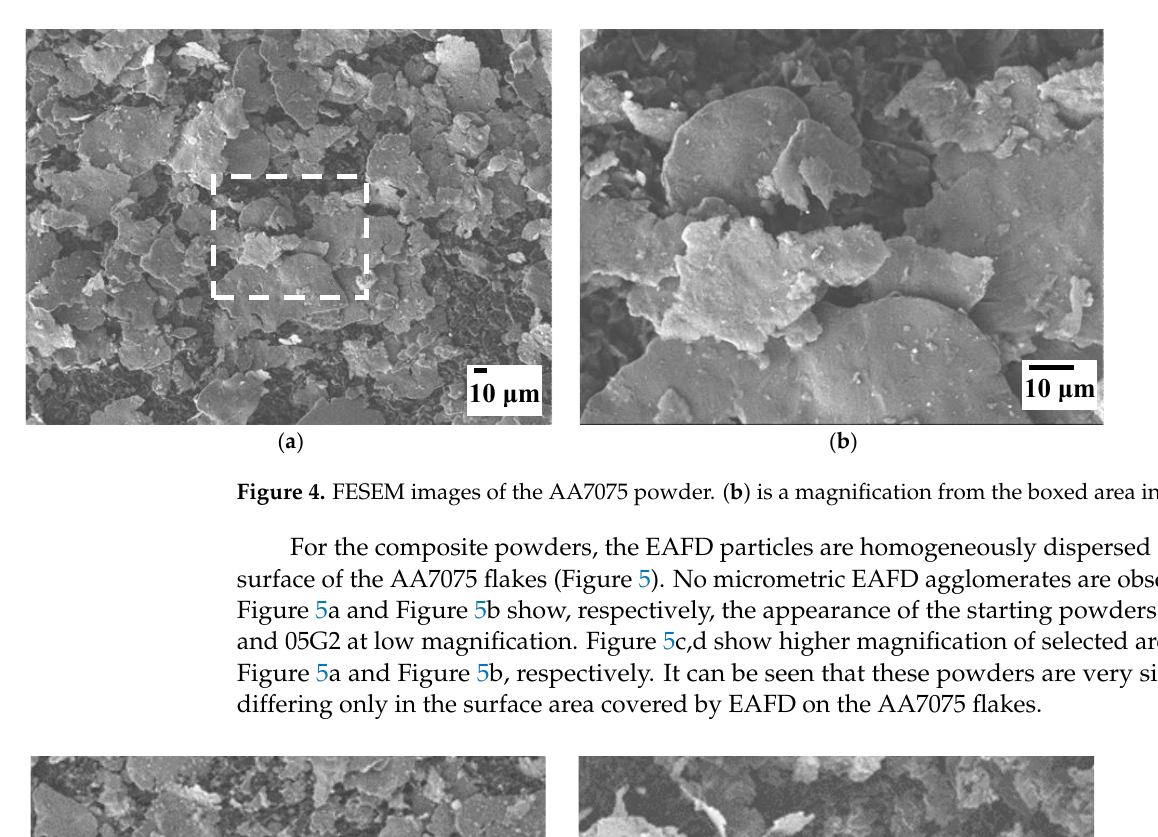
Figure 3. FESEM images of the G1 ( a , b ) and G2 ( c , d ) EAFD powders. The inset in ( c ) shows a rod- like particle observed. FESEM images (Figure 4) of the AA7075 powder milled during 1 h show that it is made up of micrometric flakes (lateral dimensions 10 – 1 00 μm, thickness about 1 μm), which is a typical morphology of milled ductile metals.